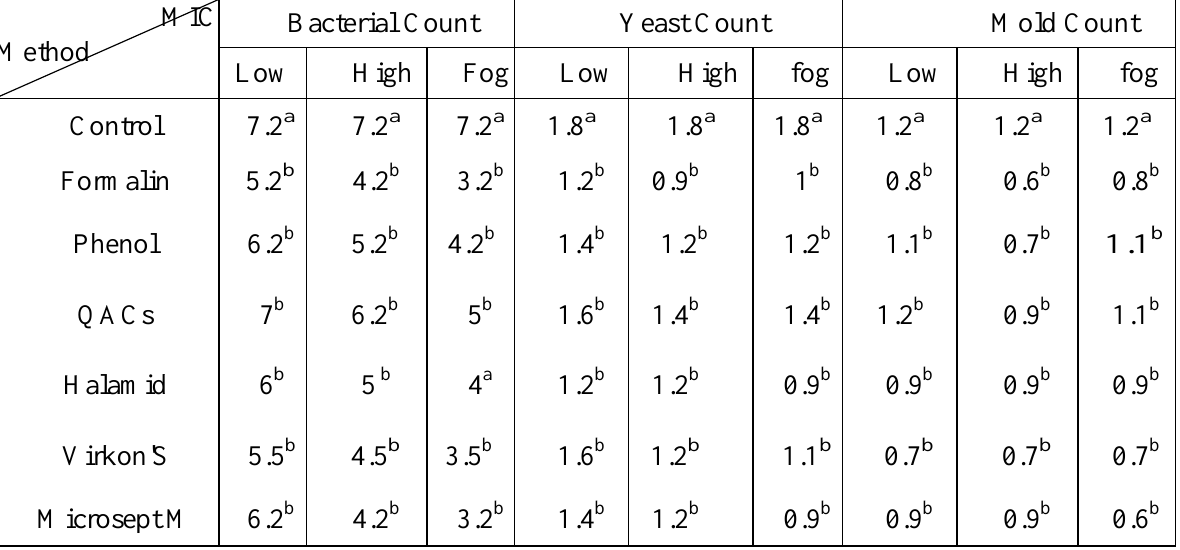
Table 5: The impact of disinfectants contact period (15 min) using low, high application level and cold